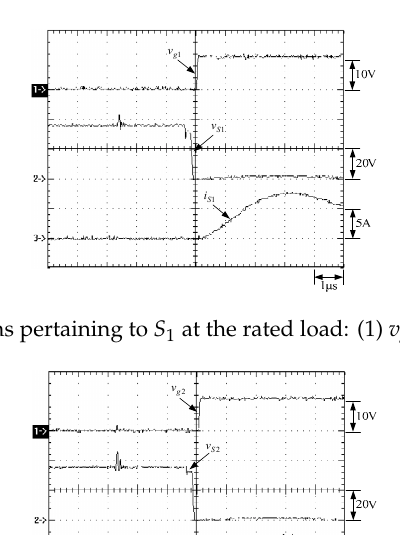
Figure 29. Waveforms pertaining to S 2 , L 2 and L r at the rated load: (1) v S 2 ; (2) i L 2 ; and (3) i Lr .